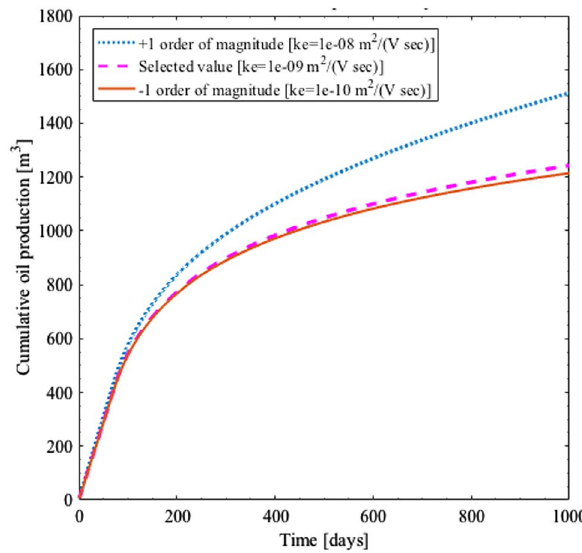
Fig. 6 Variation of cumulative oil production with absolute electro- osmotic permeability ( k eo )